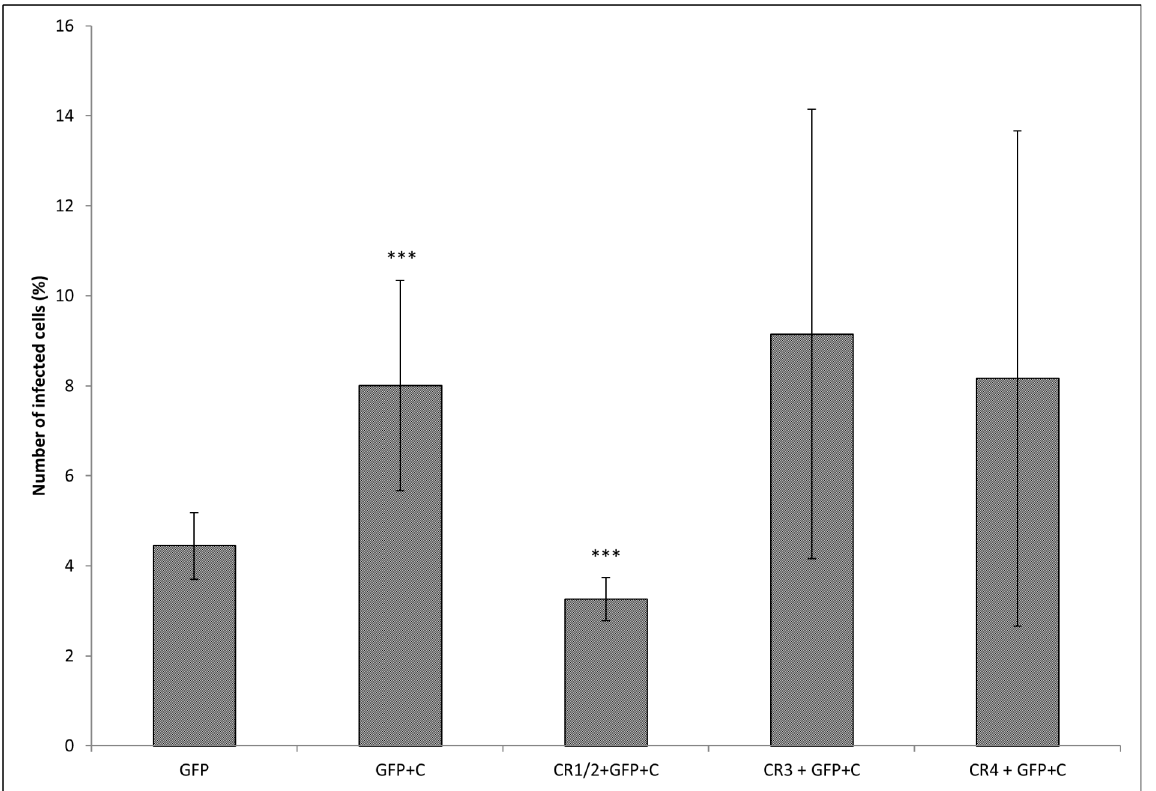
Fig 6. Blocking of CRs. Peritoneal cells were incubated with the antibodies against CD21/CD35 (CR1/2), CD11b (CR3), and CD11c (CR4). After blocking, the cells were infected for 3 h with either F . tularensis LVS/GFP (GFP) or F . tularensis LVS/GFP opsonized with complement (GFP+C) and the proportions of infected CD19 + cells were detected by flow cytometry. Error bars indicate SD around the means of samples processed in triplicate. Two-tailed t -test was used to test for significant differences against GFP. The significance of CR blocking effect was calculated between GFP+C and all groups with blocked CRs ( *** P < 0.001). Results shown from one experiment are representative of three independent